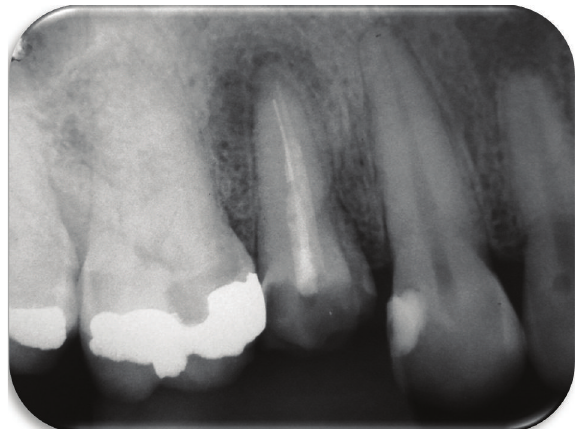
Figure 1: Initial periapical radiograph showing the fragment at the apical canal third.